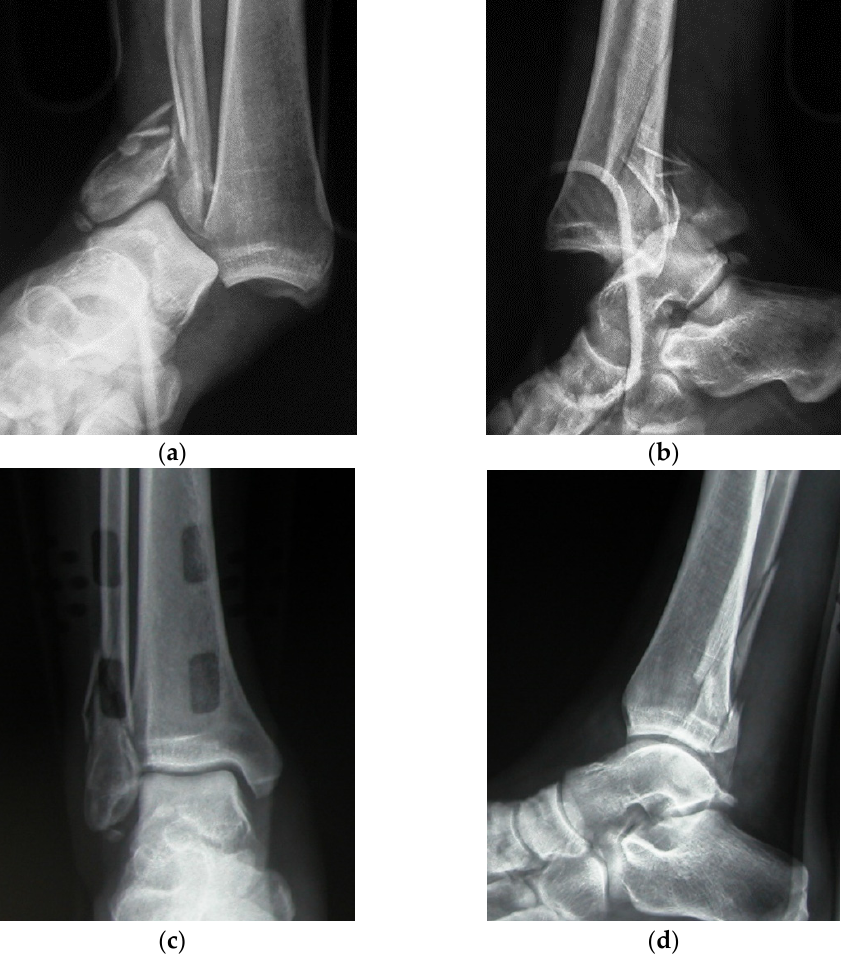
Figure 1. Radiographic examination of a fracture-dislocation of the right ankle in a 32 year-old man ( a , b ), reduced in the emergency room and temporarily stabilized by a bivalved cast ( c , d ). Statistical